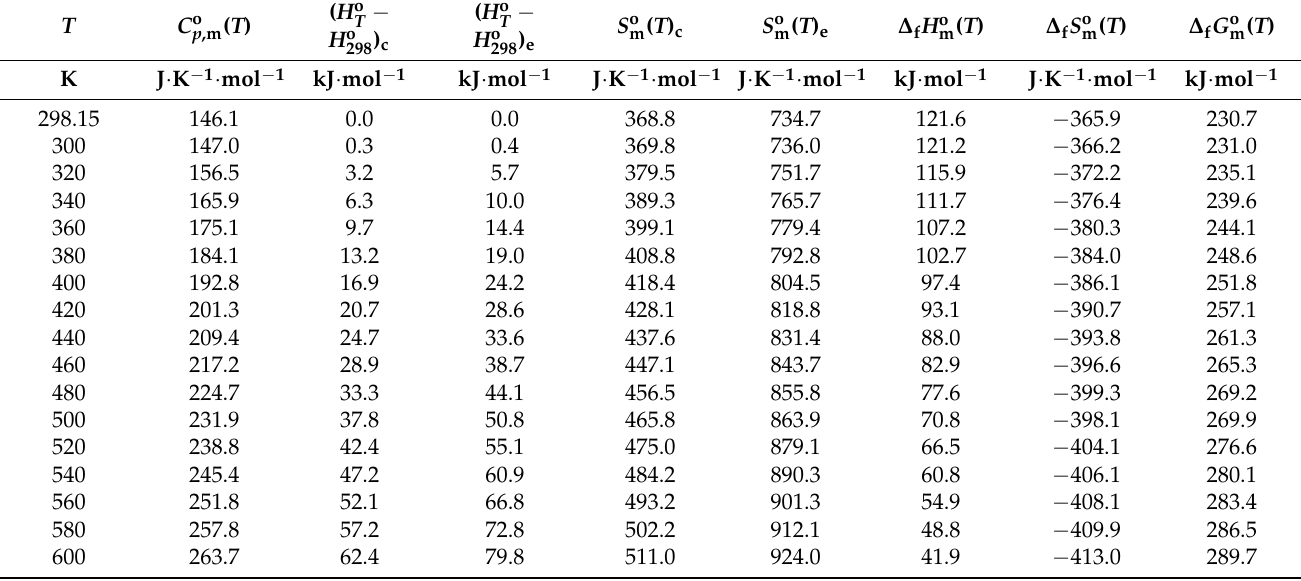
Table 11. Gas-phase standard molar thermodynamic properties of 2-methyl-indole at p = 0.1